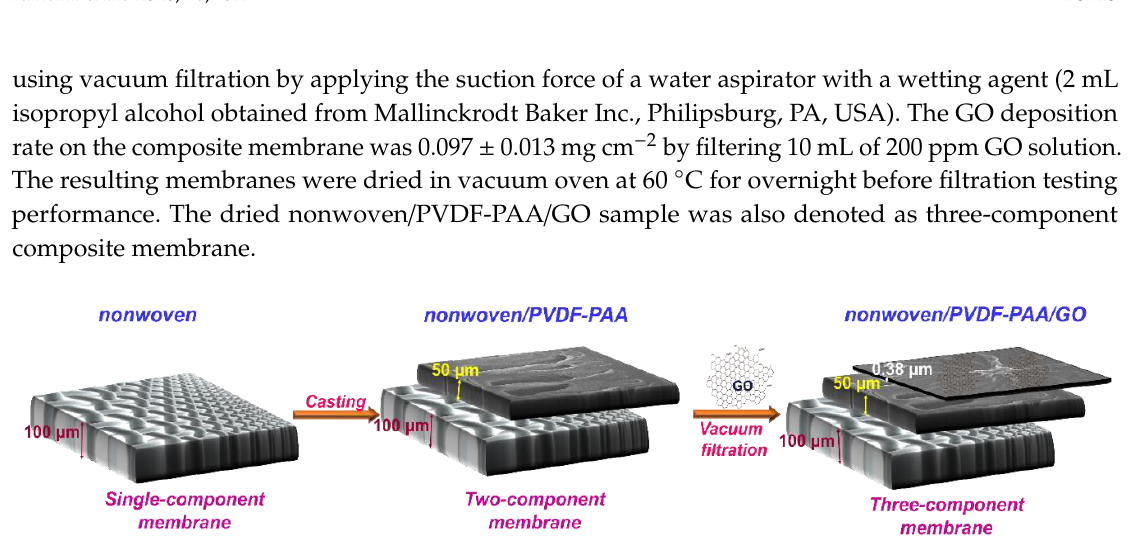
Figure 1. Schematic diagram for the formation of three-component composite membrane.